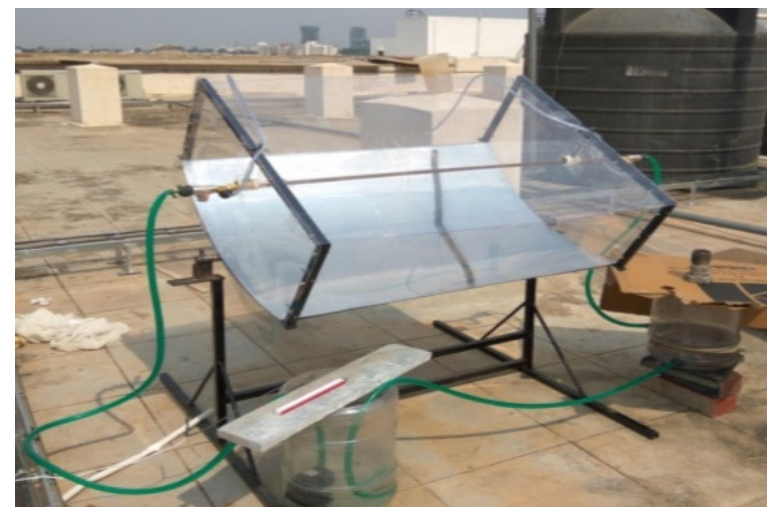
Fig. 2. Photograph of the experimental setup